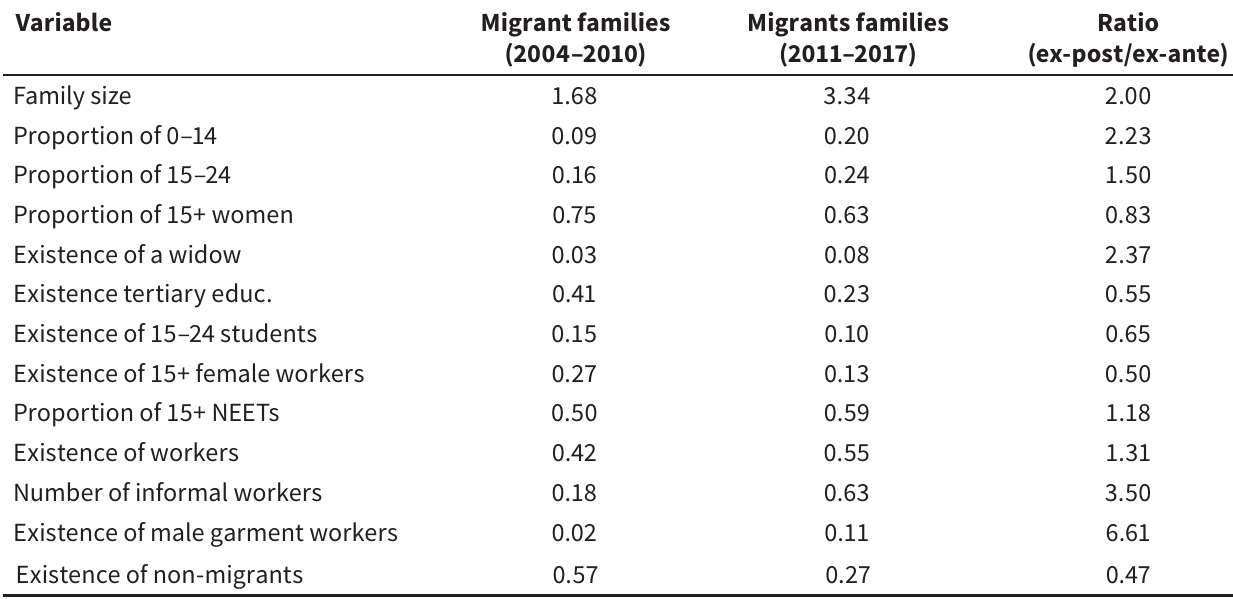
Summary statistics at the family level: before